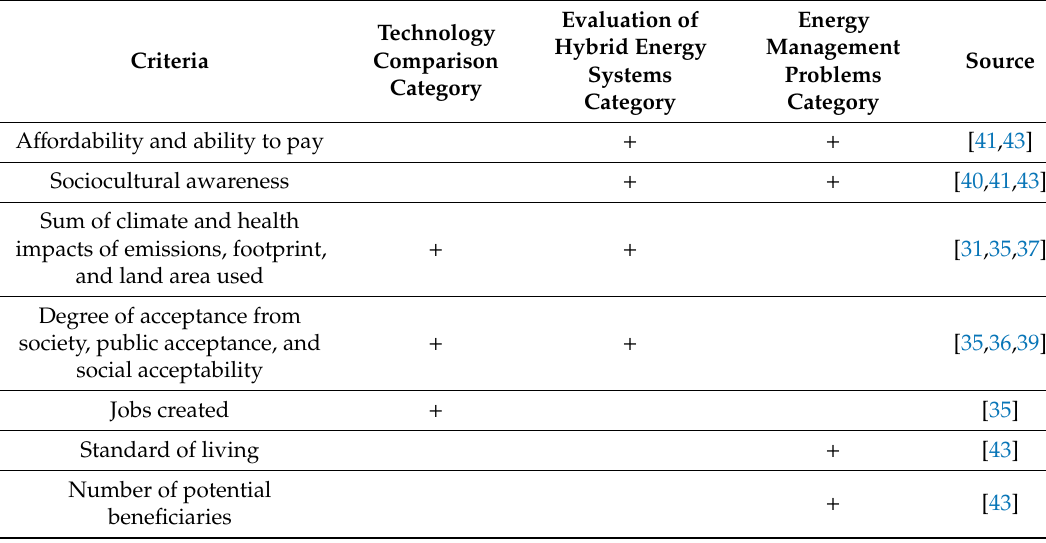
Table 6. The overview of social